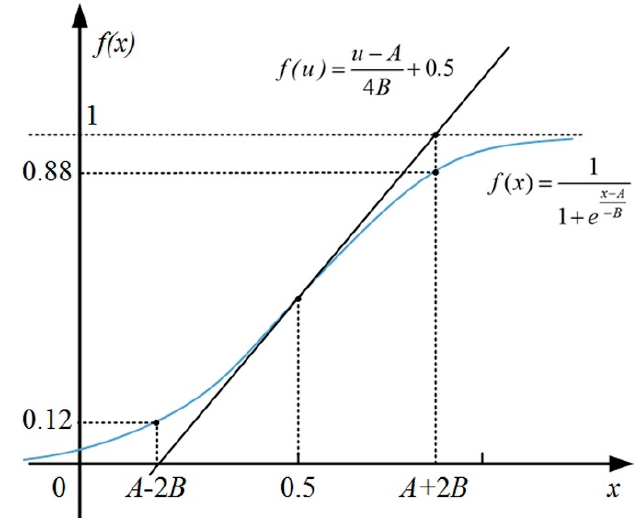
Figure 6. The tangential equation for sigmoid function.